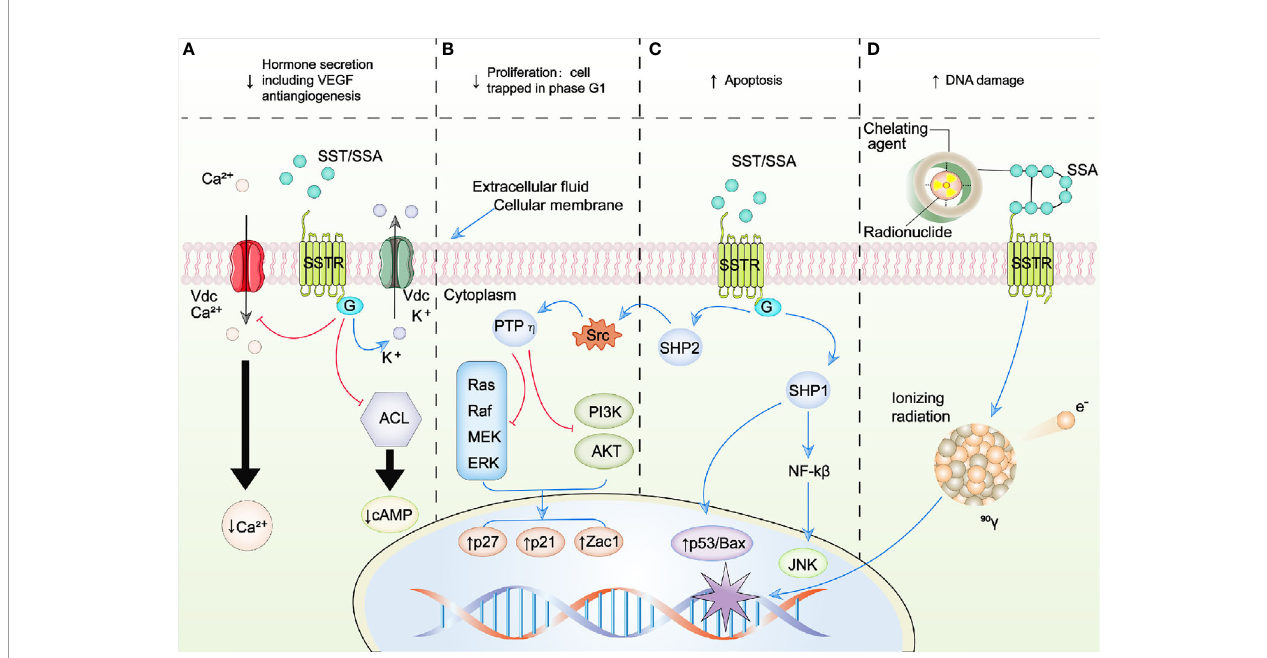
FIGURE 2 | Schematic representation of SSTR-targeted therapy. (A – C) represent the intracellular signaling pathways modulated by SSA/SST. (D) represents the schematic of peptide receptor radionuclide therapy (PRRT). Blue arrows, activation; red arrows, inhibition; ↑ , increase; ↓ , decrease; ACL, adenylate cyclase; AKT, protein kinase B; BAX, B-cell lymphoma 2 (BCL2)-associated X protein; Ca2+, calcium; G, G protein; JNK, c-Jun N-terminal kinases; K+, potassium; MEK, mitogen- activated protein kinase kinase; NF k B, nuclear factor kappa B; PI3K, phosphoinositide 3 kinase; PTP h , phosphotyrosine phosphatase h ; raf, rapidly accelerated fi brosarcoma kinase; ras, RAS kinase; SHP1, Src homology phosphatase 1; SHP2, Src homology phosphatase 2; Src, Rous sarcoma oncogene; SSAs, somatostatin analogues; SST, somatostatin; SSTR, somatostatin receptor; Vdc, voltage-dependent channel; VEGF, vascular endothelial growth factor; Zac1, zinc fi nger protein regulator of apoptosis and cell cycle